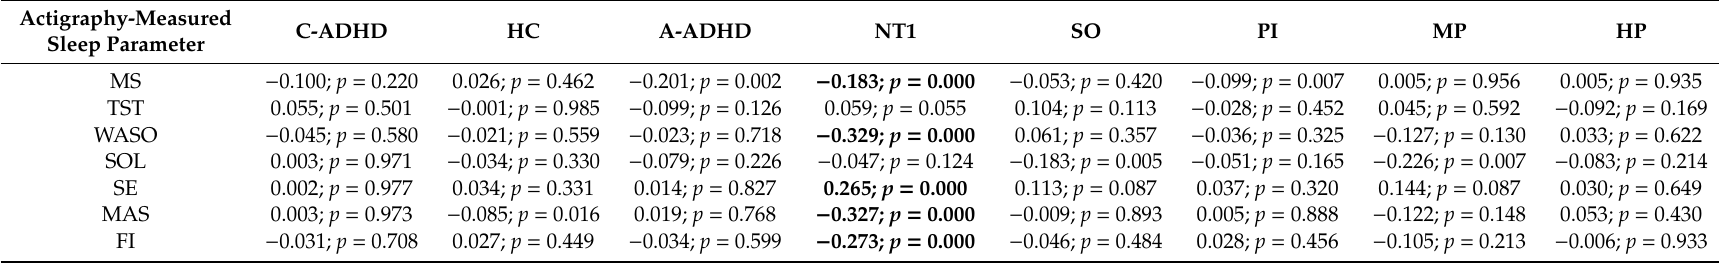
Table 4. Point-biserial correlations, within each group, between each actigraphic sleep parameter and PM performance at get-up time (activity